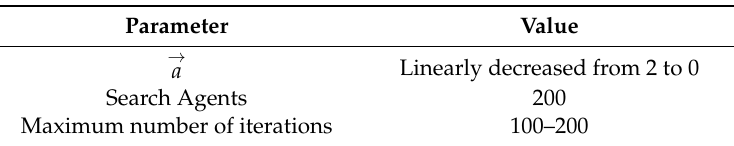
Table A2. The parameter settings of